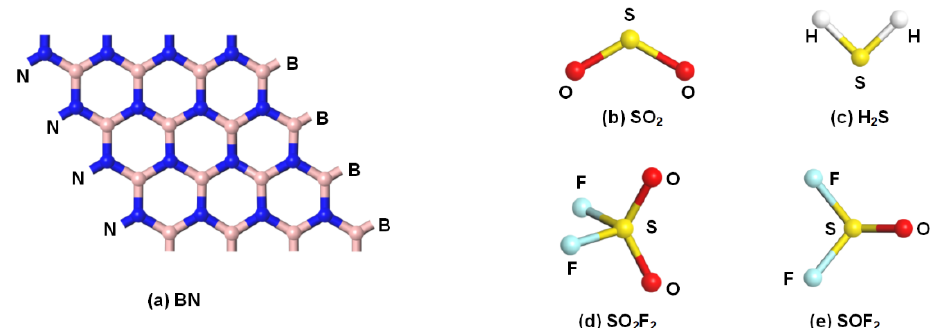
Figure 1. ( a ) Configurations of pure BN monolayer. ( b – e ) Configurations of the molecules of SF 6 decomposition products.